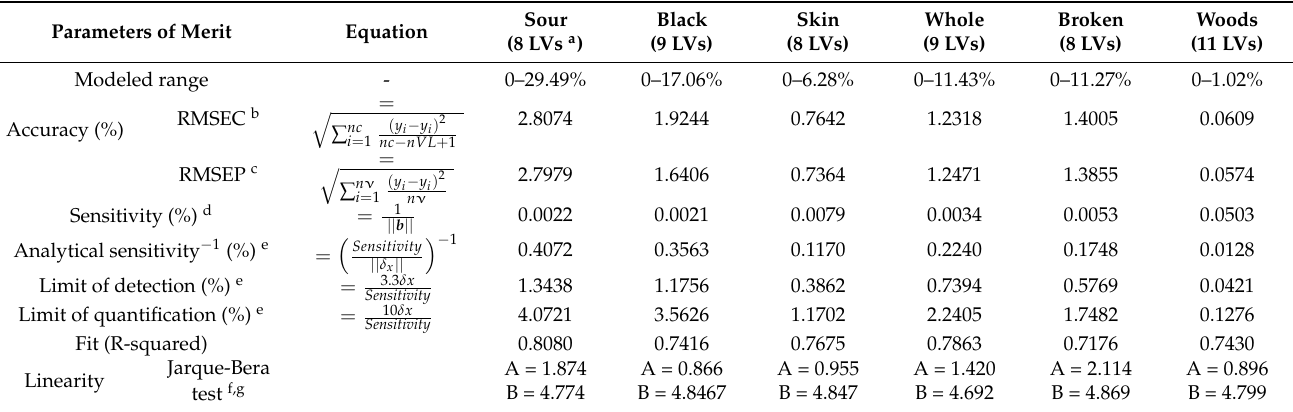
Table 1. Analytical parameters of merit for the multiproduct PLS model.